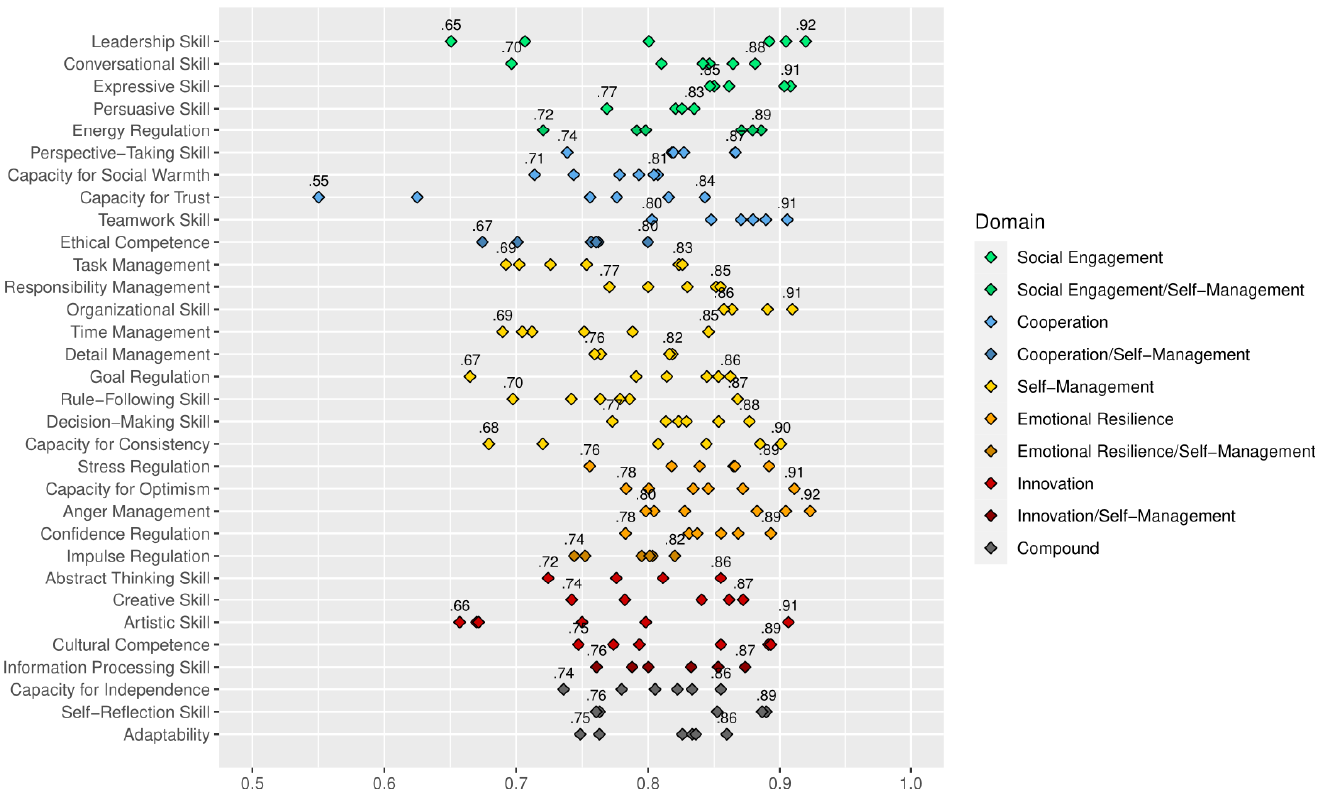
) of the BESSI-G v0.2 items on their respective factors (Study 𝜆𝜆